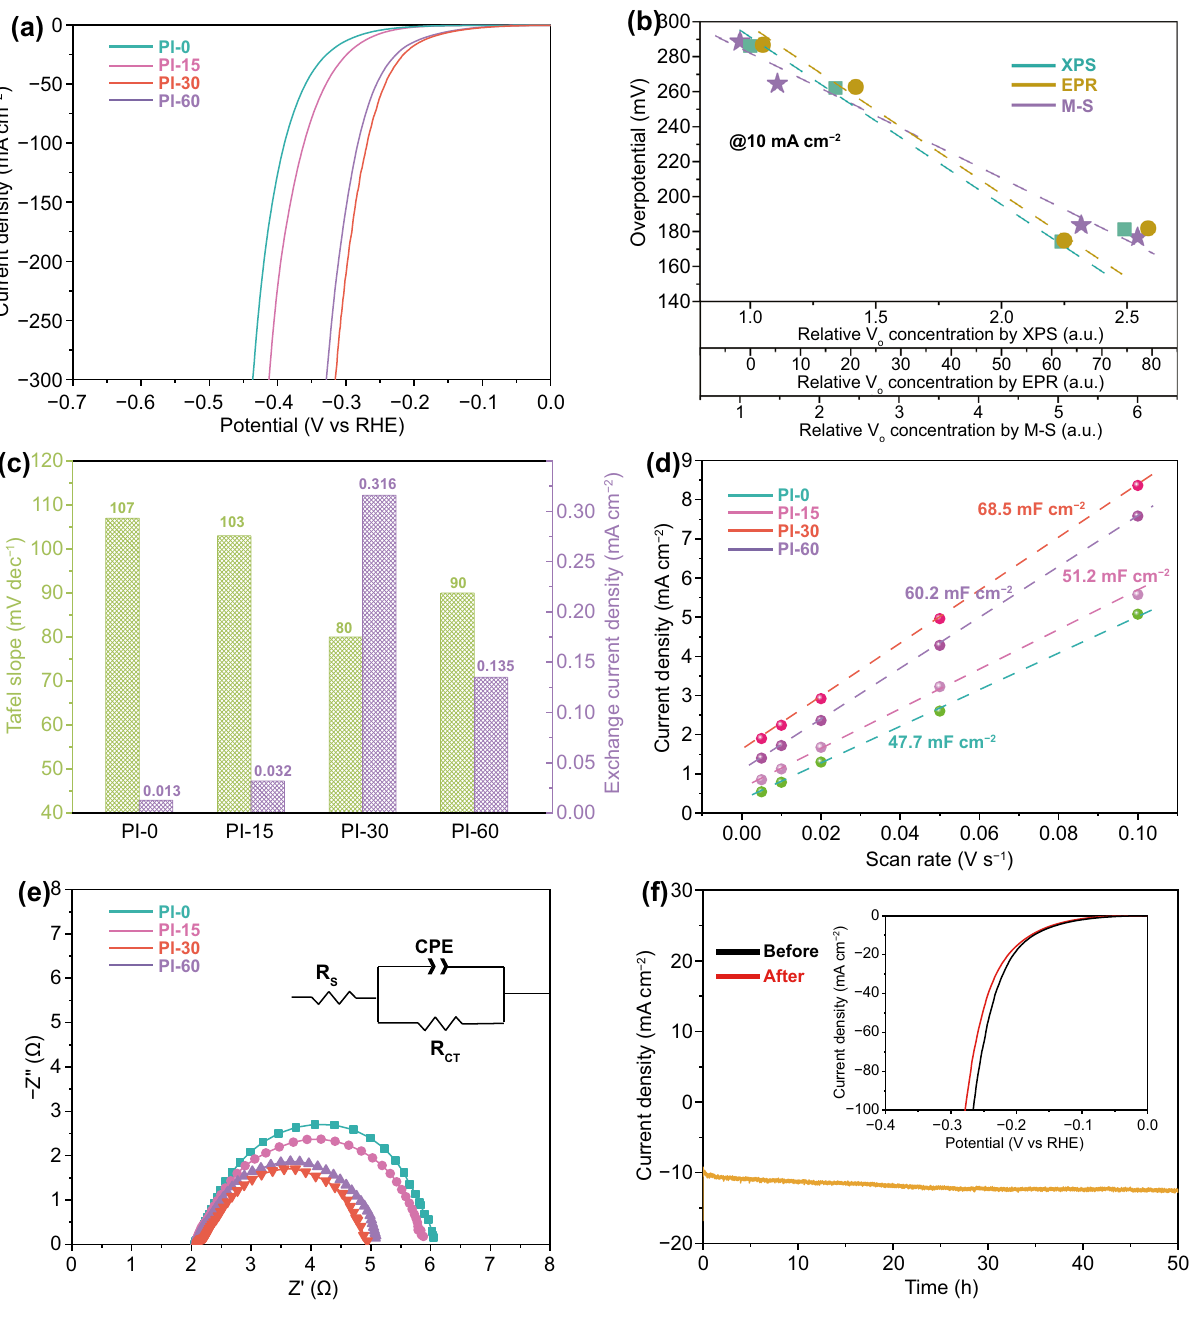
Fig. 5 Electrocatalysis performance of 2D Bi 2 O 3 nanosheets in 1.0 M KOH. Polarization curves collected at a scan rate of 5 mV s −1 ( a ). The relationship of the overpotentials needed to reach j = 10 mA cm −2 and the relative oxygen vacancy concentrations obtained from EPR, XPS and EPR measurements ( b ). Tafel slopes and exchange current densities for 2D Bi 2 O 3 nanosheets with different oxygen vacancy concentrations ( c ). Calculated C dl plots of 2D Bi 2 O 3 nanosheets at 10 mA cm −2 ( d ). EIS measurements on different 2D Bi 2 O 3 nanosheets. ( f ) Stability test on the Pl-30 up to 50 h ( e